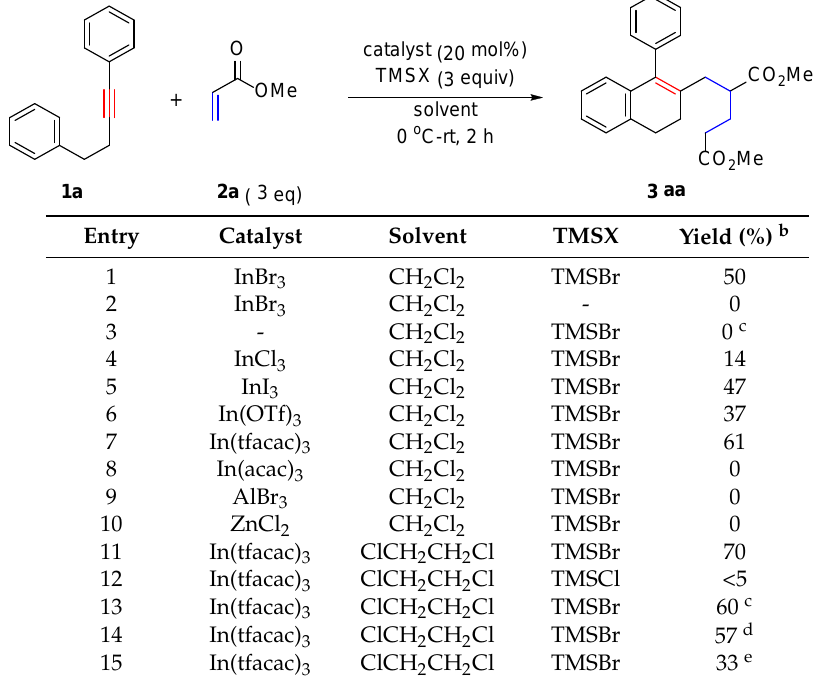
Table 1. The In(III)-TMSBr-catalyzed cascade reaction of diarylalkyne 1a with methyl acrylate ( 2a ) a .